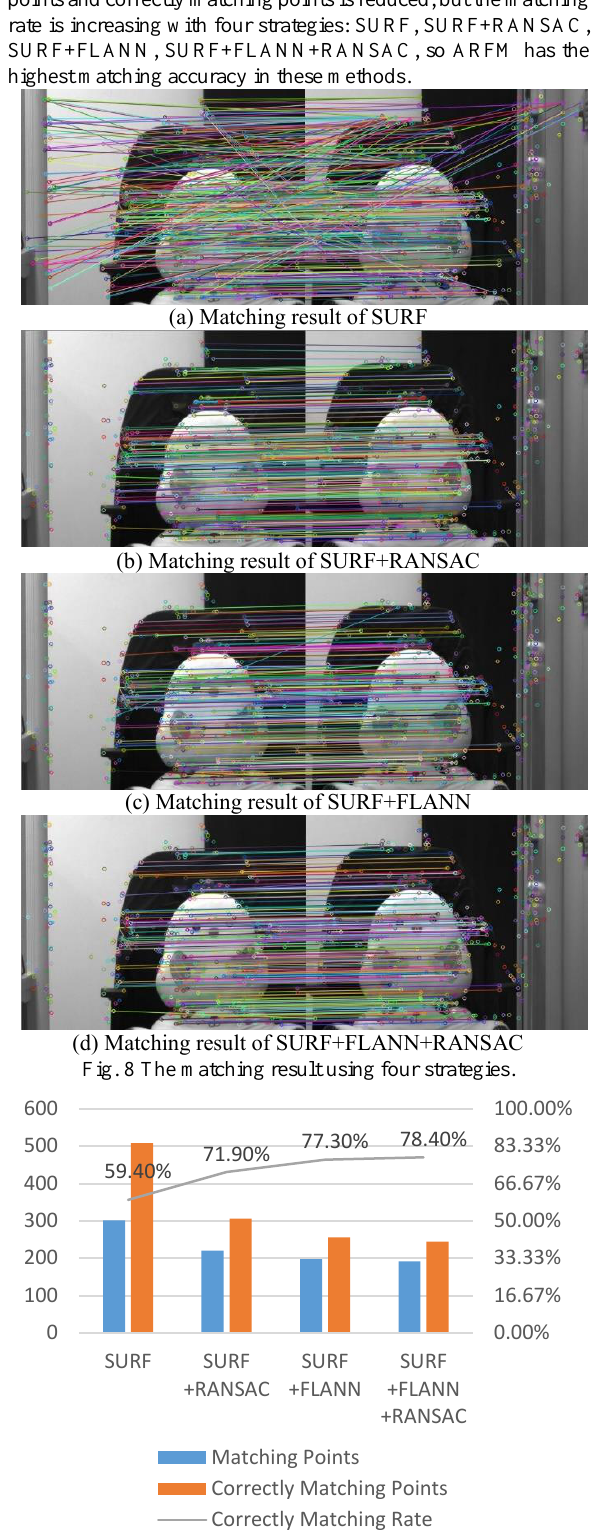
Fig. 9 The statistics of matching result with four